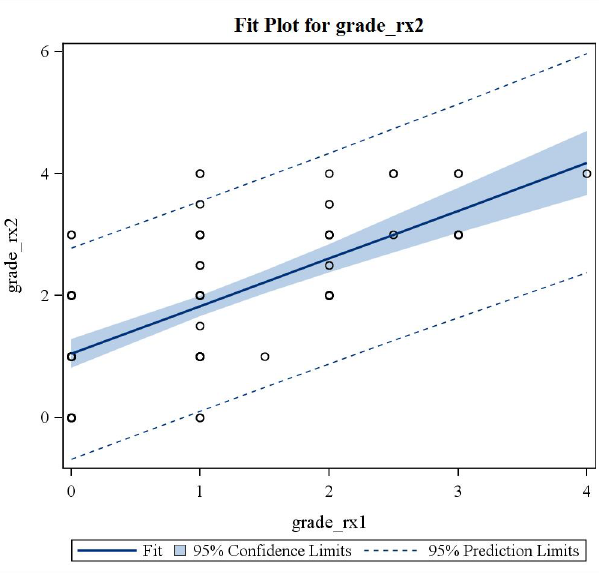
Fig 8. Fit-plot regression curve for evolution of Kellgren-Lawrence grade on consecutive radiographs.